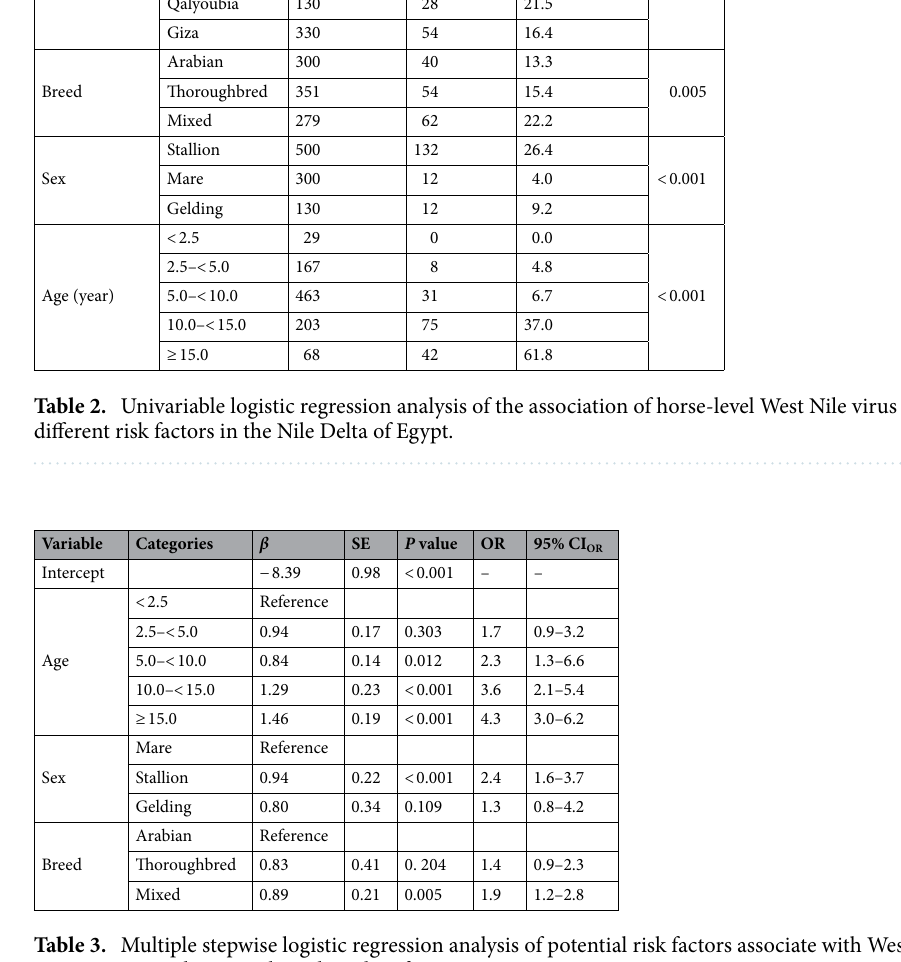
Table 3. Multiple stepwise logistic regression analysis of potential risk factors associate with West Nile virus seropositivity in horse in the Nile Delta of Egypt.